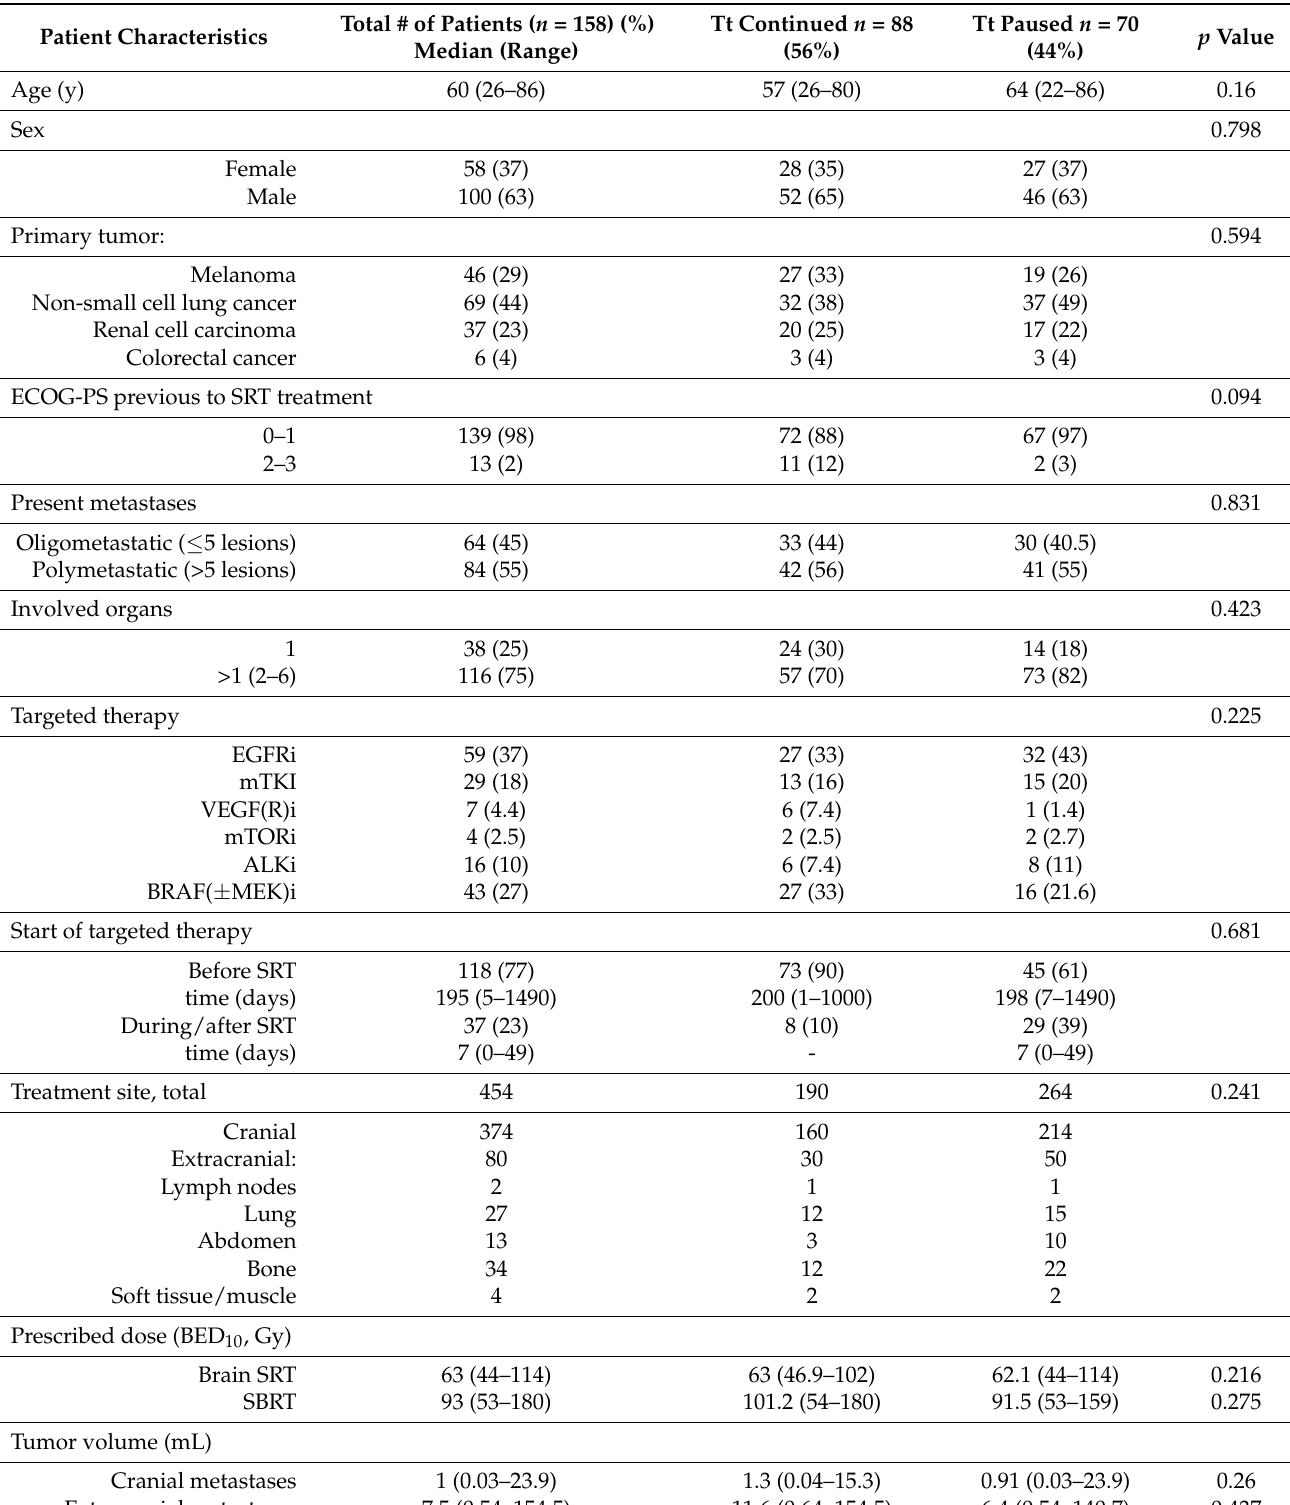
Table 1. Patient characteristics subdivided into patients where targeted therapy (TT) was interrupted during stereotactic radiotherapy and patients where TT was